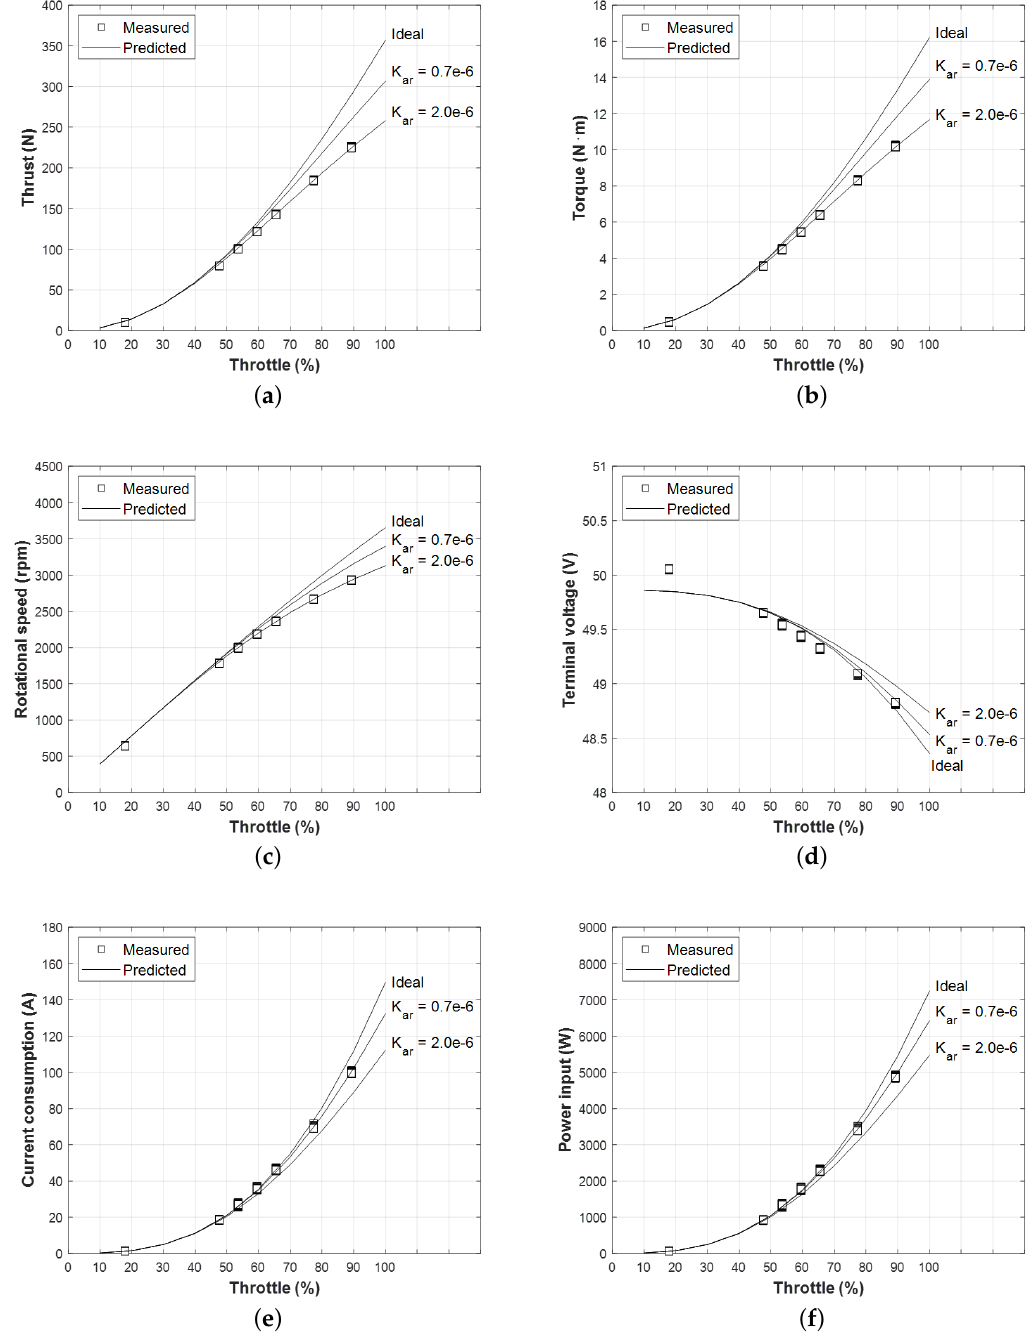
Figure 24. Performance prediction results of sample set 1 (T-motor U15II with T-motor G40x13.1) compared with static thrust test results: ( a ) Thrust, ( b ) torque, ( c ) rotational speed, ( d ) terminal voltage, ( e ) current consumption, and ( f ) power